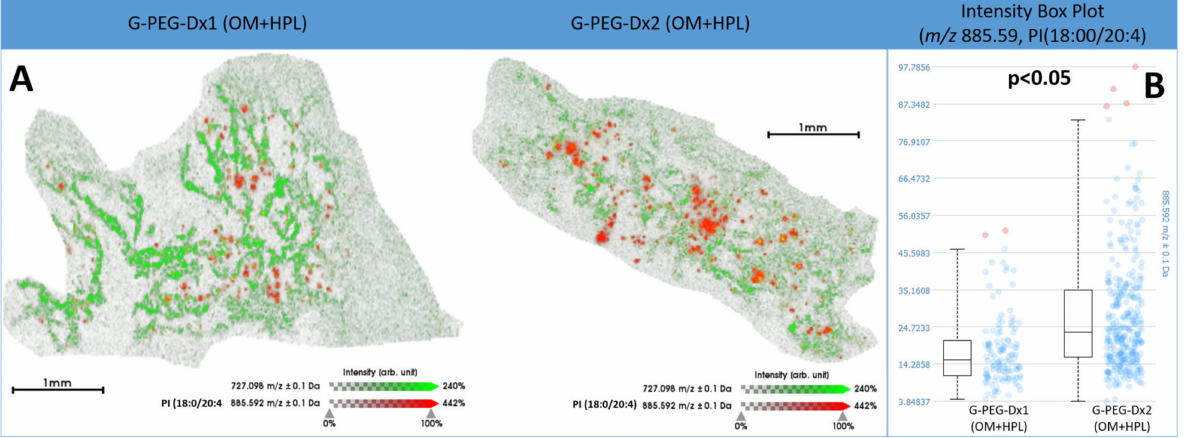
Figure 8. Cell distribution and relative intensity of PI (18:0/20:4) in G-PEG-Dx1 and G-PEG-Dx2. ( A ) MALDI-MSI overlay visualizing the distribution of m / z 885.59, PI(18:0/20:4), within the hMSCs (red) and m / z 727.098 (green) indicating the scaffold structure. Both scale and intensity bars are provided. ( B ) Intensity box plot indicating the ion intensity of PI(18:0/20:4 in G-PEG-Dx1 (OM+HPL) and G-PEG-Dx2 (OM+HPL). The identity of PI(18:0/20:4) was confirmed by MALDI-MS/MS and the product ion fragments generated by its dissociation are presented in Supplementary Table